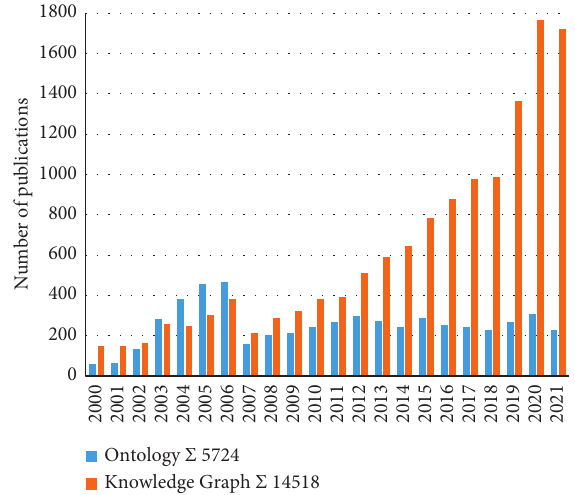
Figure 1: Number of publications since 2000 in the topic of on- tology and knowledge